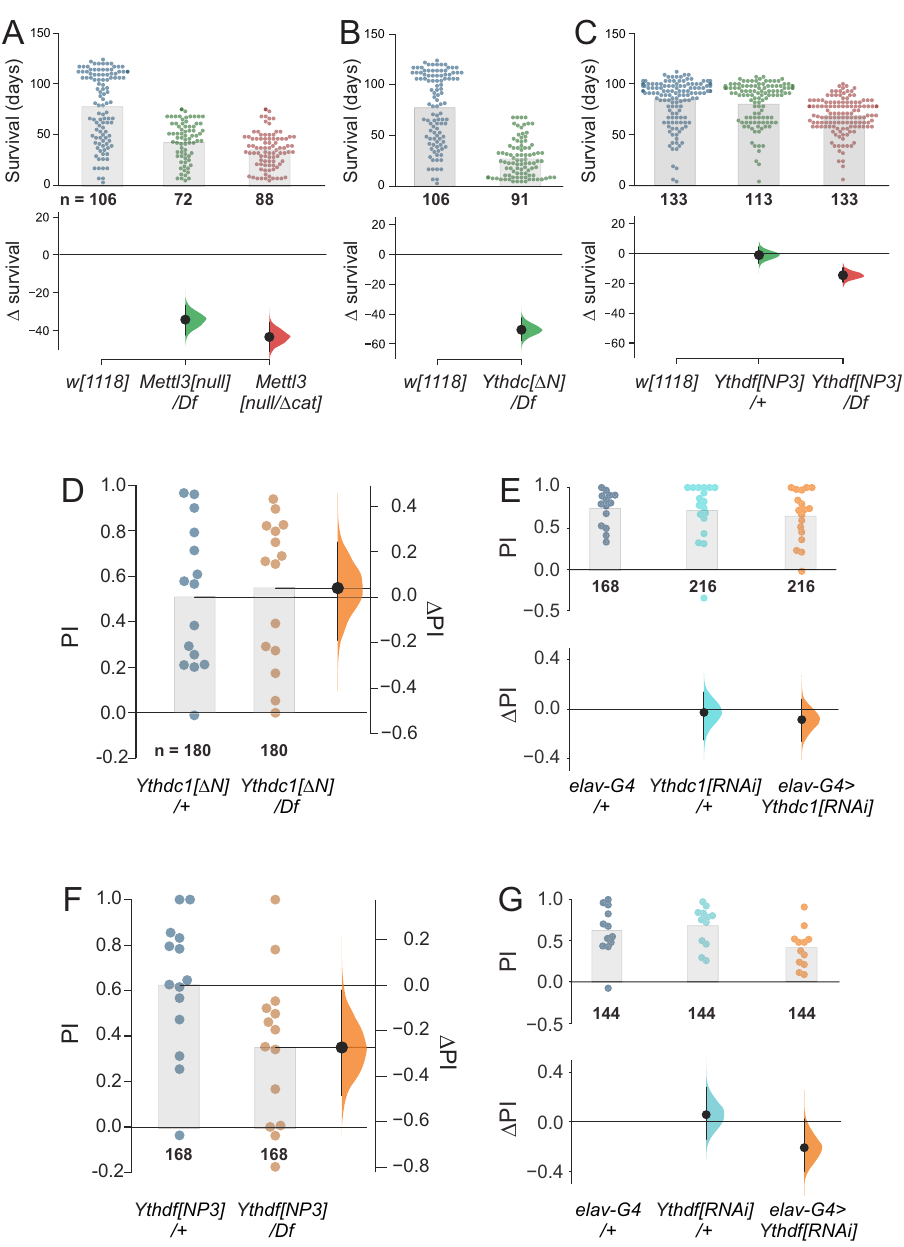
Fig. 3 Ythdf, but not Ythdc1, mediates the role of m 6 A in Drosophila STM. A – C Lifespan measurements of m 6 A writer and reader mutants. Mutants